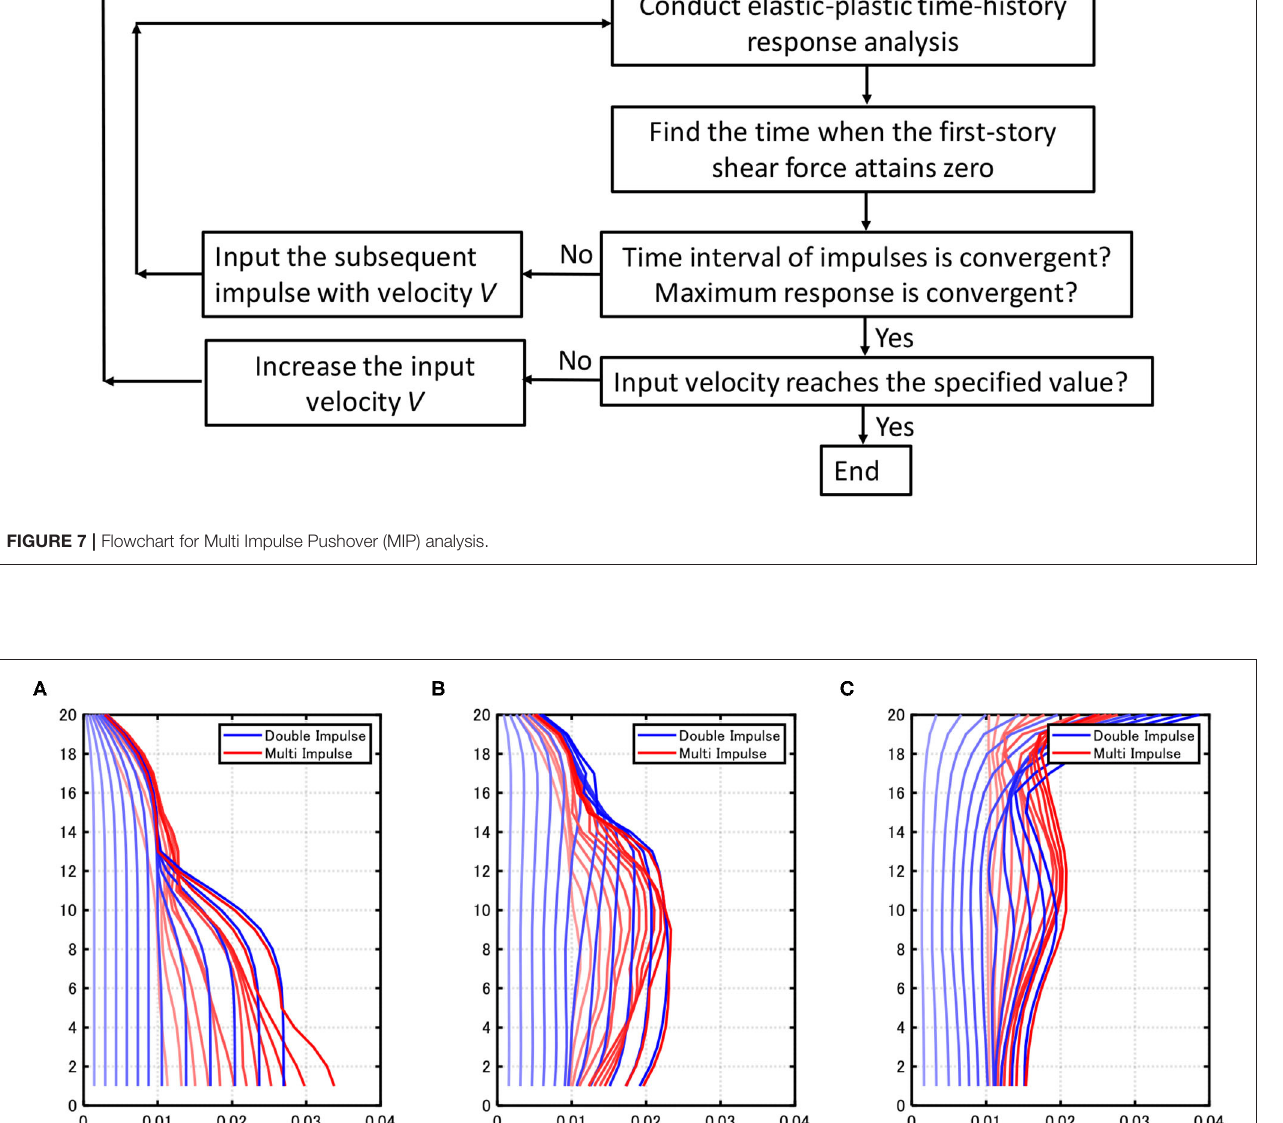
Frontiers in Built Environment |